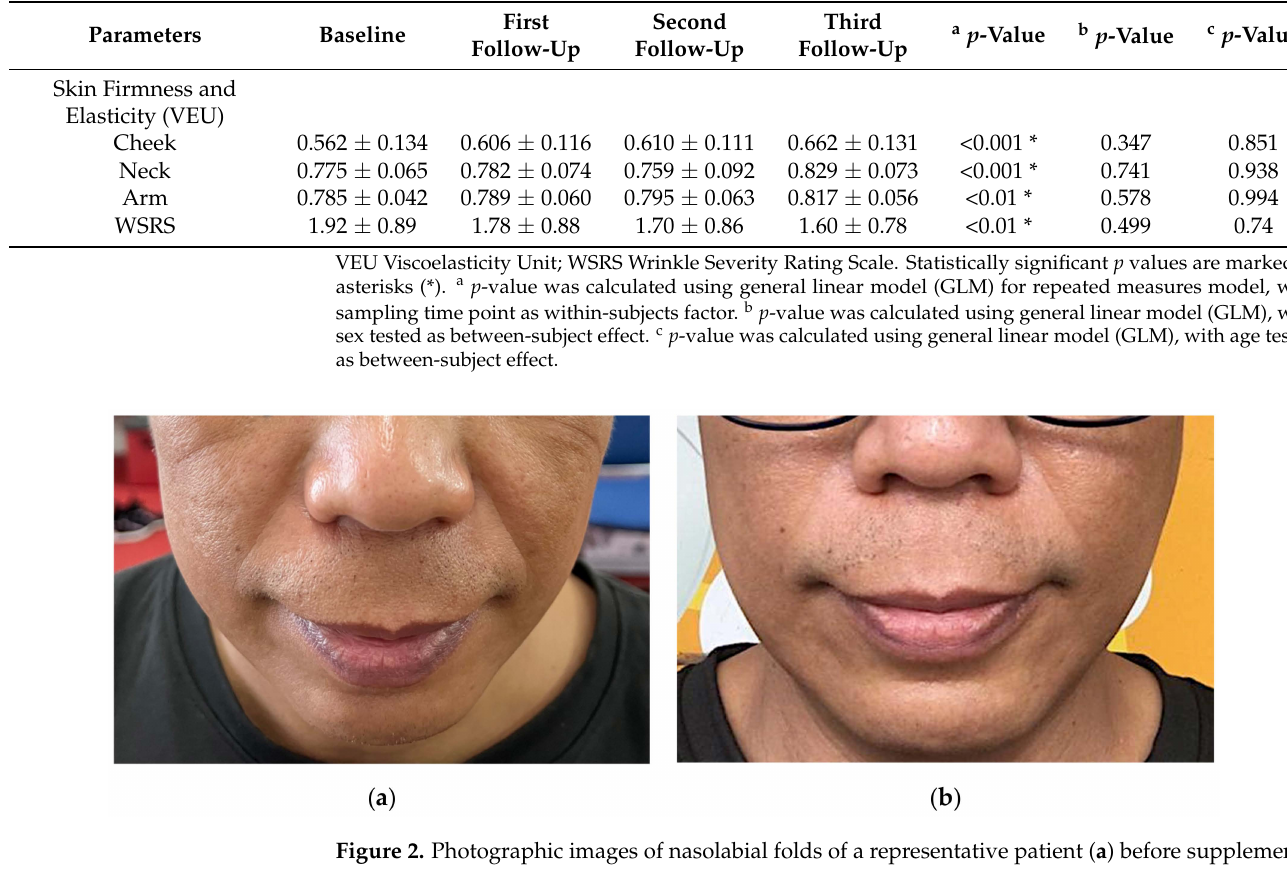
Table 3. Changes in skin firmness and elasticity of participants during study.